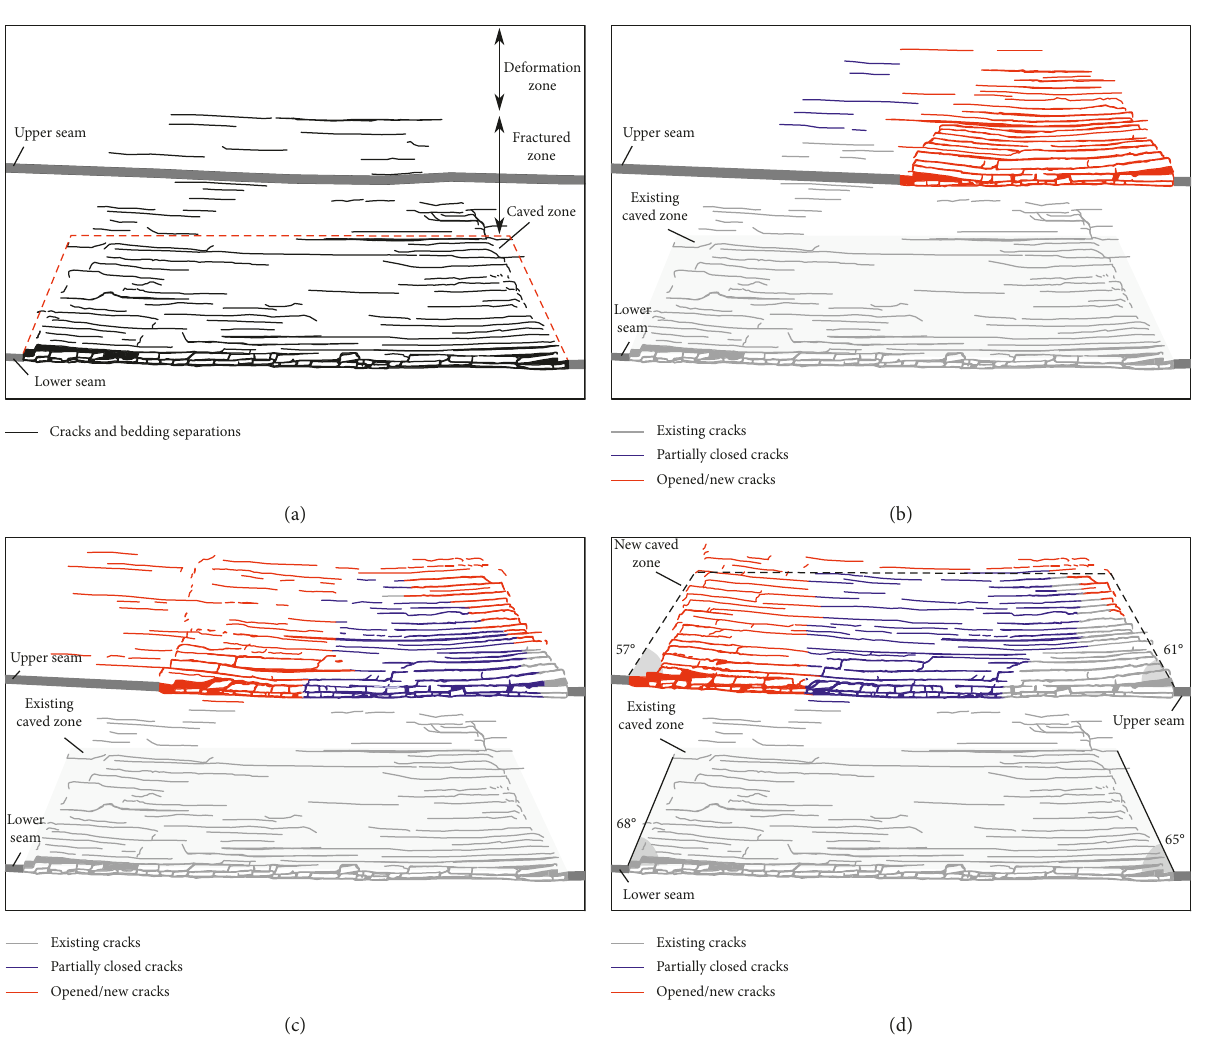
Figure 10: Crack propagation after extraction of (a) lower panel and (b–d) different segments of the upper panel in Case